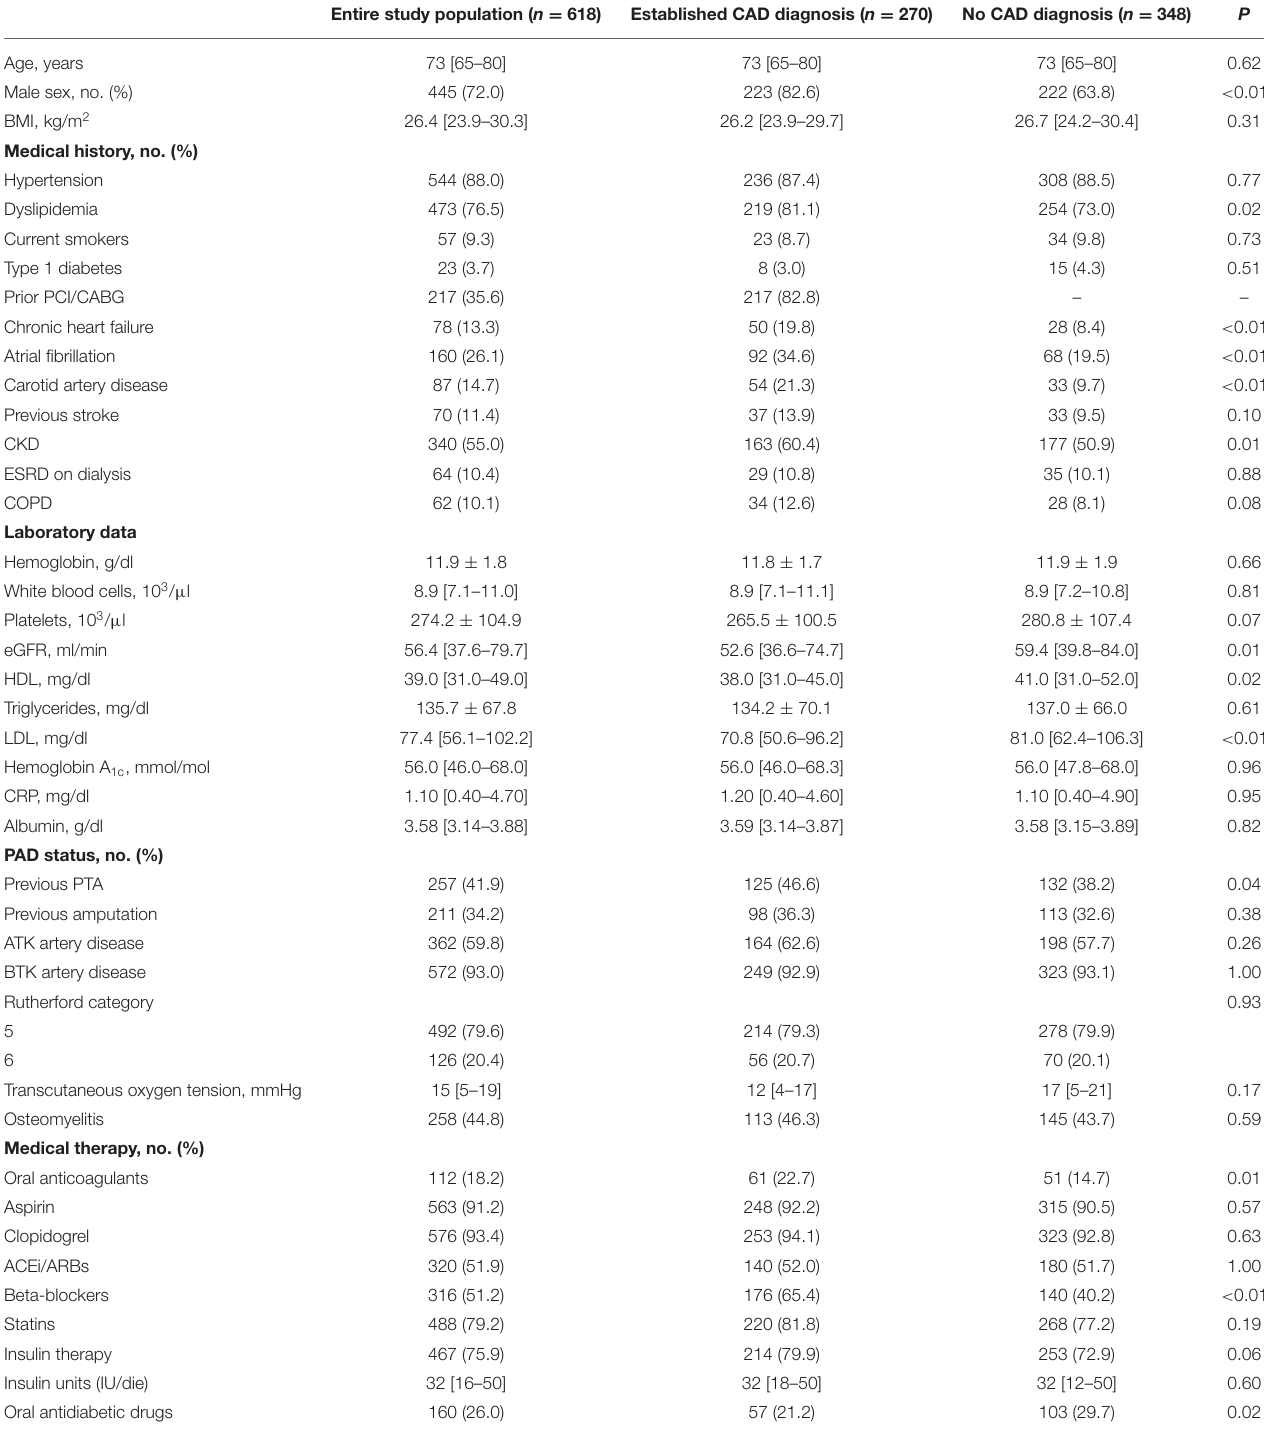
TABLE 1 | Characteristics of the study population. Entire study population ( n = 618) Established CAD diagnosis ( n =